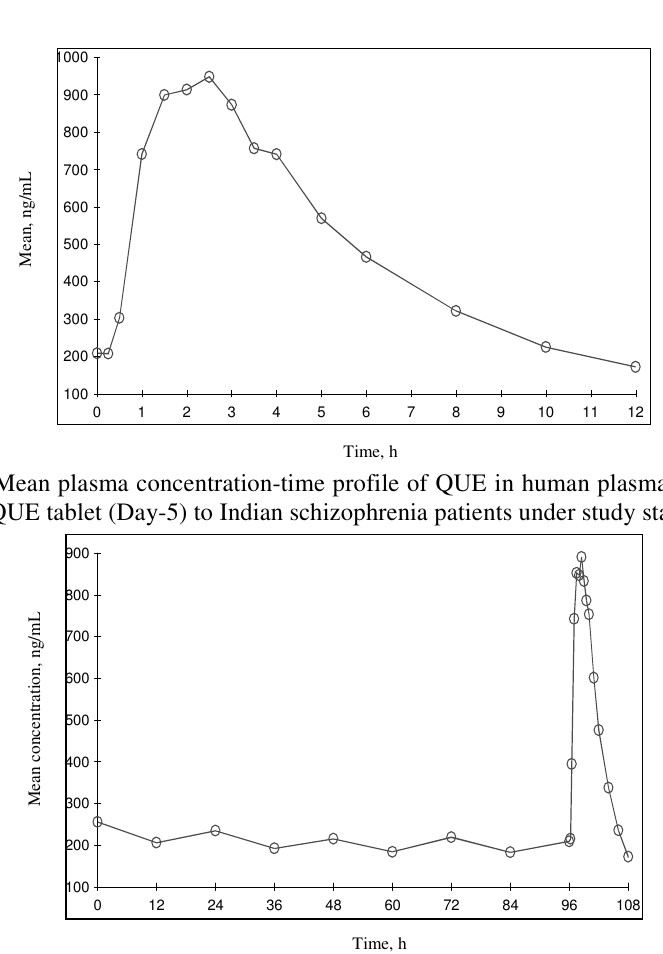
Figure 4a. The Mean plot of quetiapine plasma concentration Vs. time from day 1 to 5 showing study